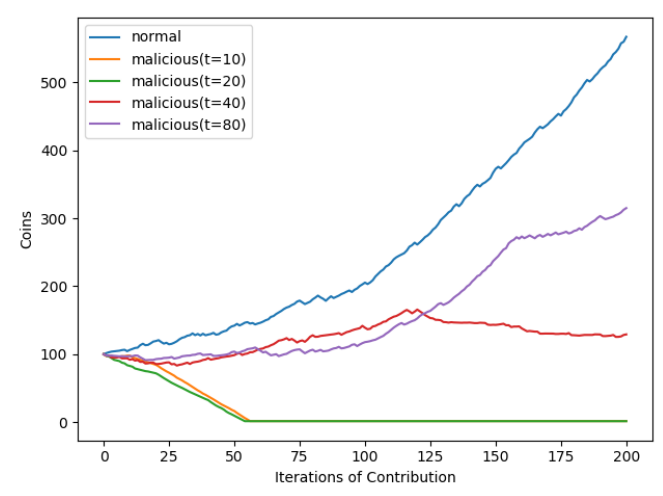
Figure 8. Changes of cryptocurrencies held by each contributor and attacker ( p = 16).